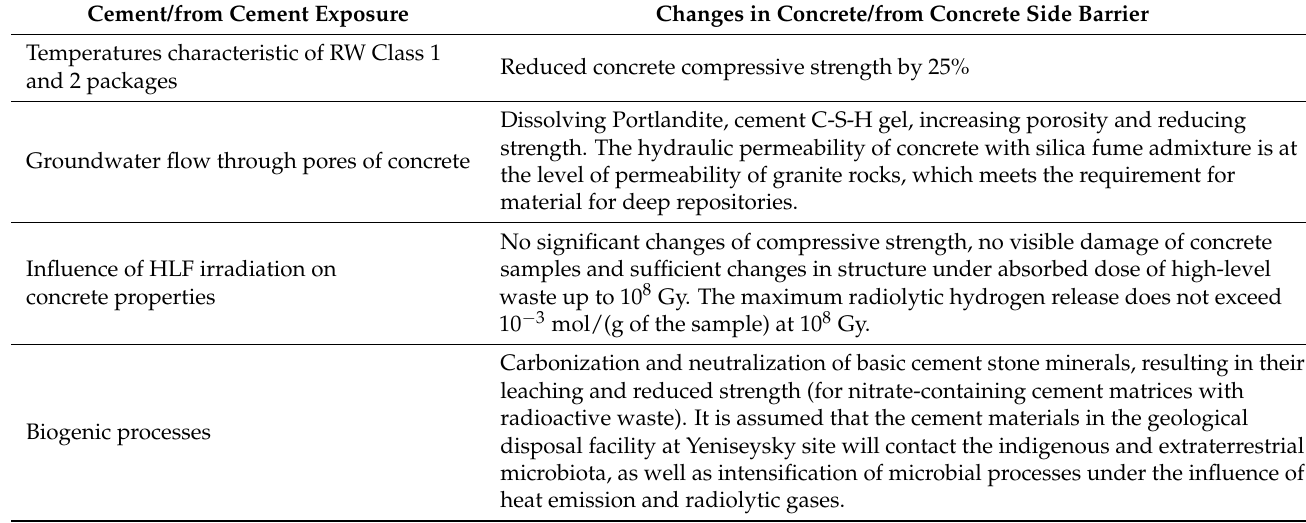
Table 7. Transformation of barriers based on cement materials under external factors of geological disposal